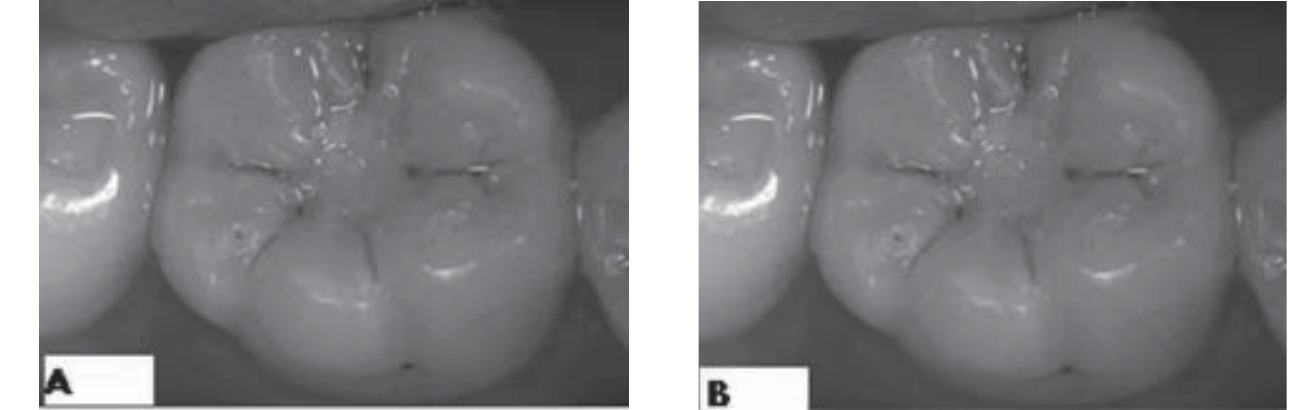
Fig. 2A and 2B - Packable composite resins restorations after 2 years of evaluation, showing Alpha score according to USPHS criteria.